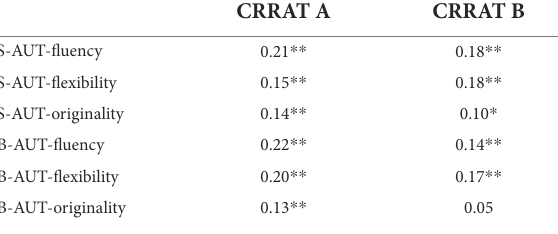
TABLE 5 Correlation coefficients between AUTs and CRRATs. CRRAT A CRRAT B